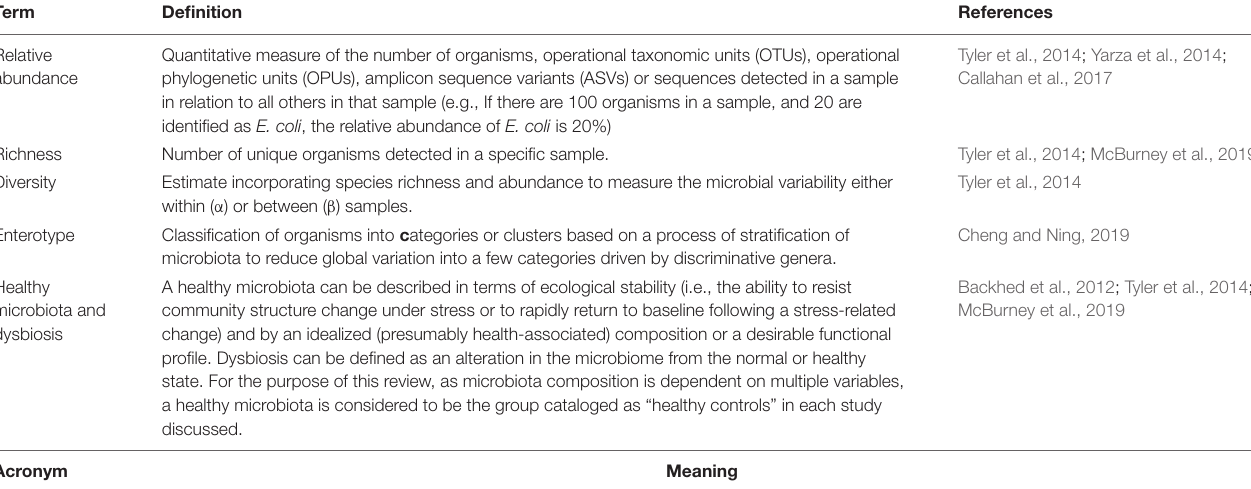
TABLE 1 | Definition of relevant terms included in microbiota studies, and acronyms used in this